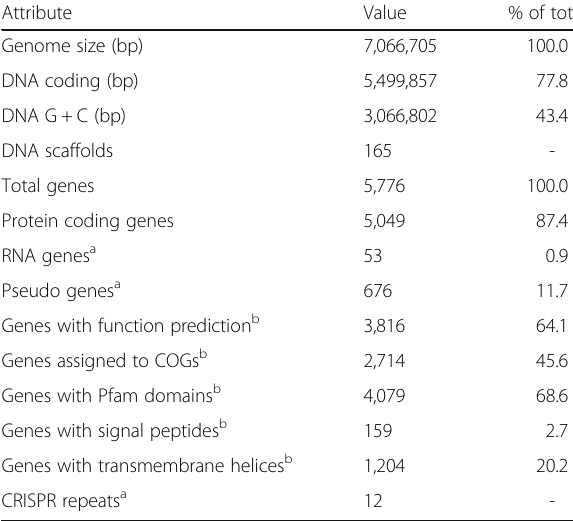
Table 3 Genome statistics